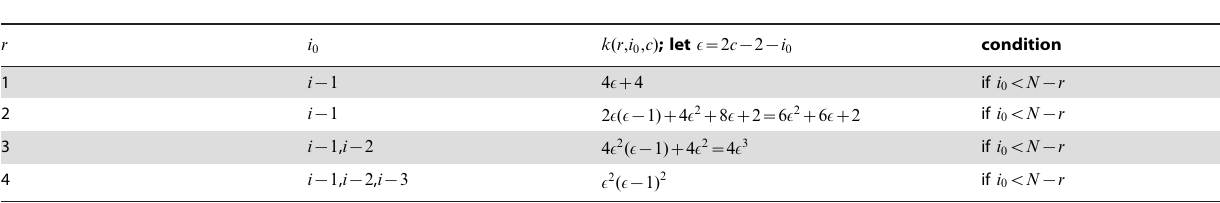
Table 1. Counts for points lying exactly on the border region